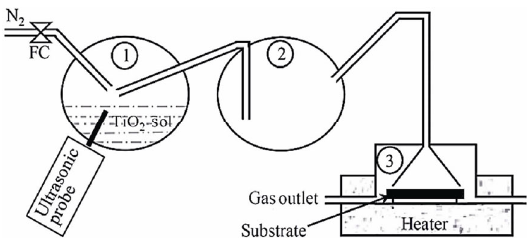
Fig. 1 Schematic illustration of the thin film deposition